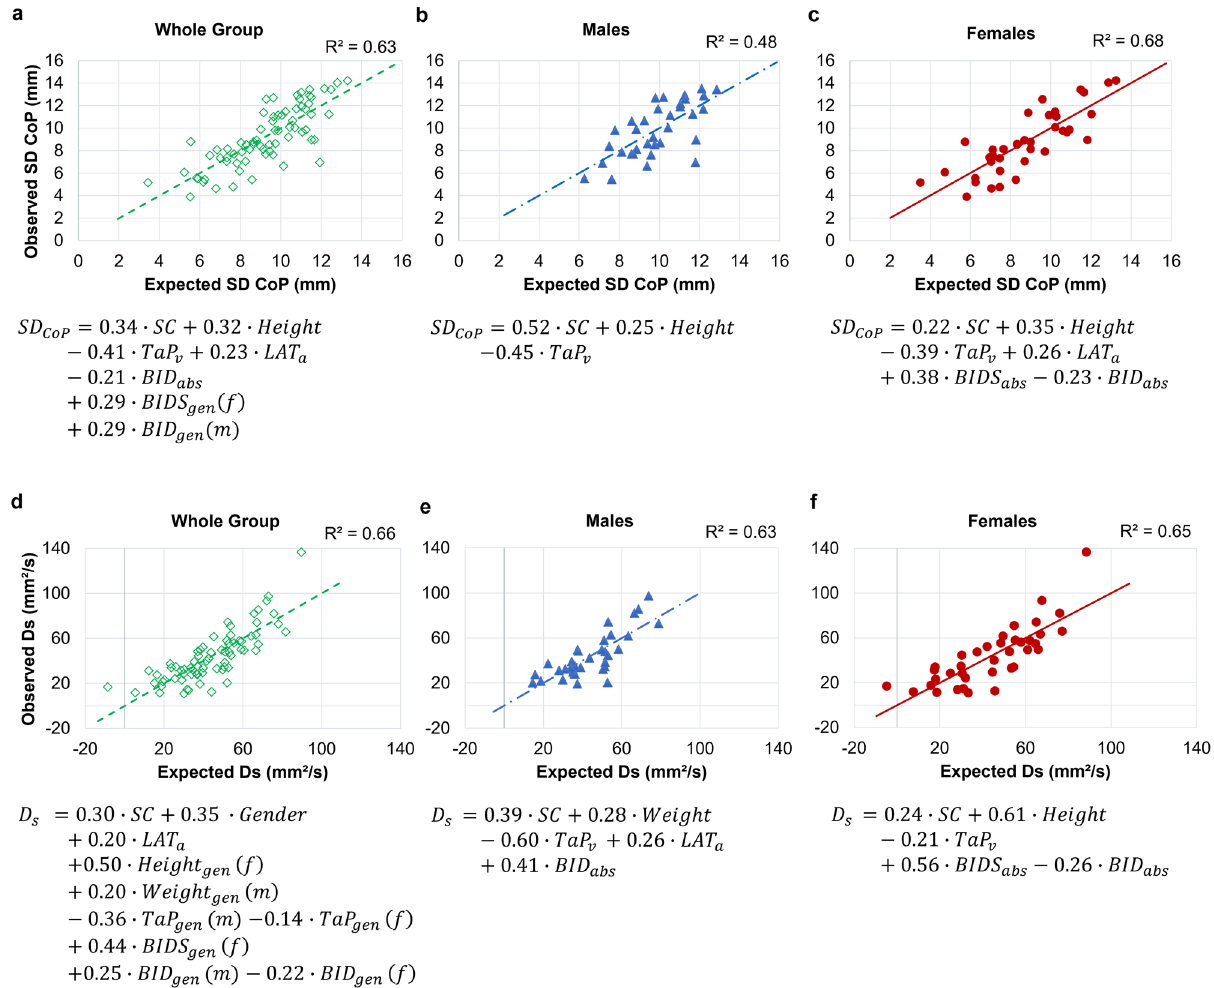
Figure 3. Best regression plots with minimal number of predictors. Sway variability (SD CoP): upper row ( a – c ); Short-term stochastic activity ( D s ): lower row ( d – f ); whole group ( a , d ): gender-interactions ( gen ): for males